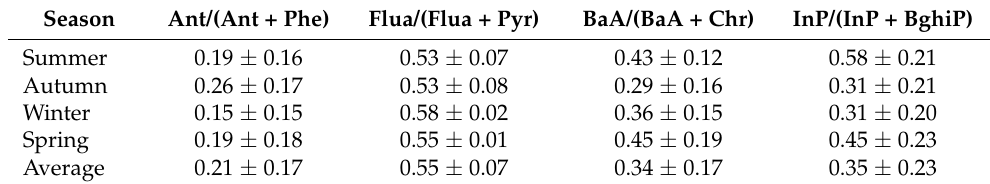
Table 5. Characteristic diagnostic ratios of PM 2.5 -bound PAH